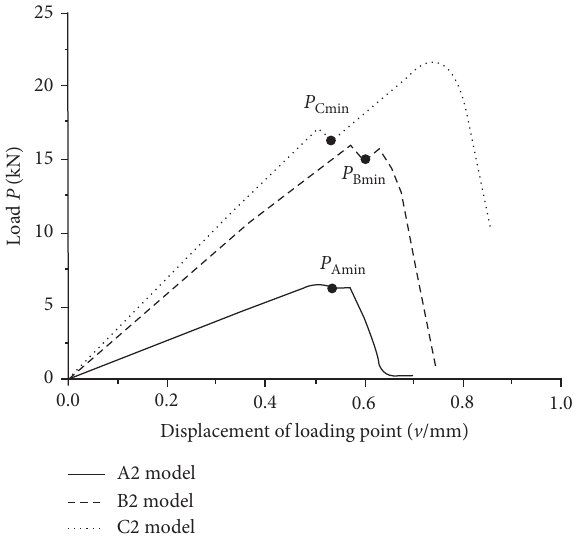
Figure 19: P - v curve of the ECFSD